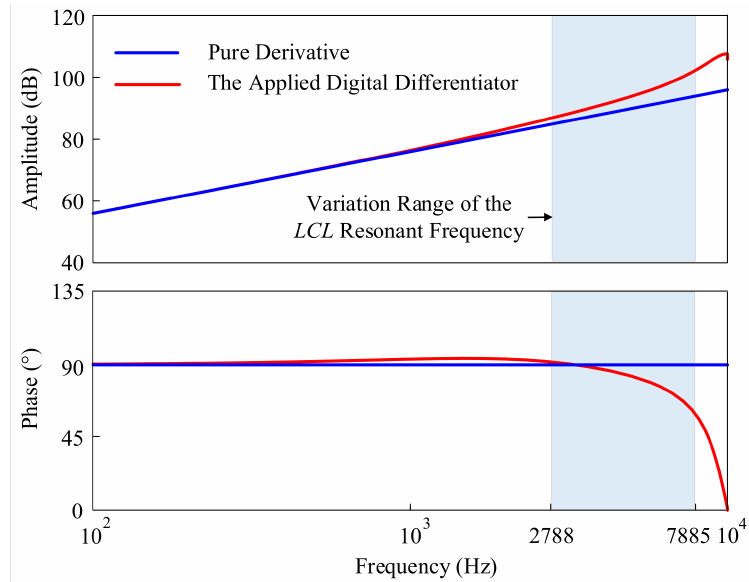
Figure 18. Bode plots of the digital differentiator and the pure